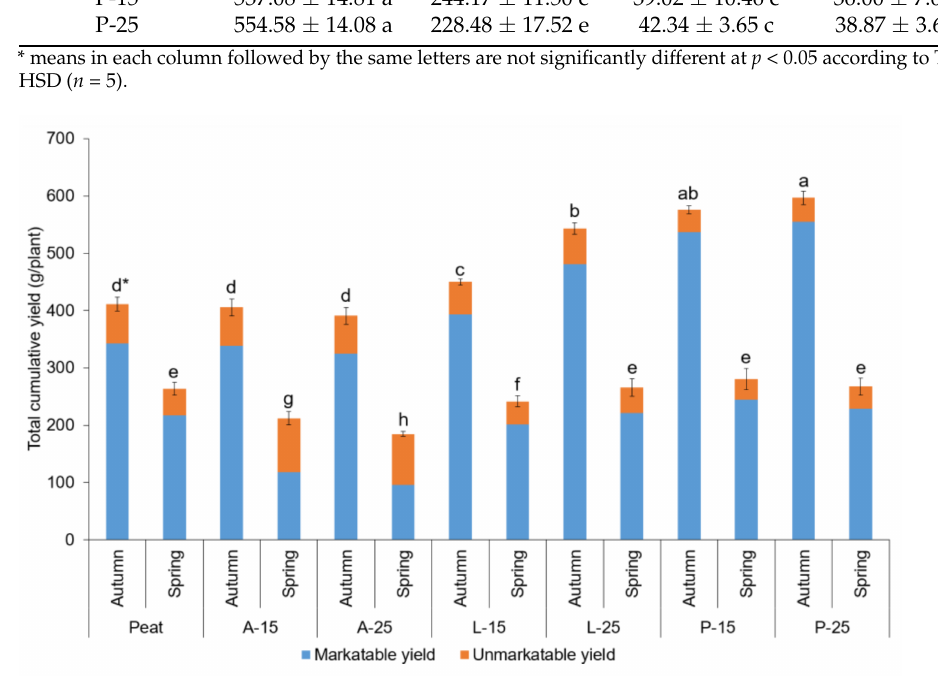
Figure 4. Total cumulative yield (g · plant − 1 ) as influenced by substrates and planting seasons. * means followed by the same letter are not significantly different at p < 0.05 according to Tukey’s HSD ( n =